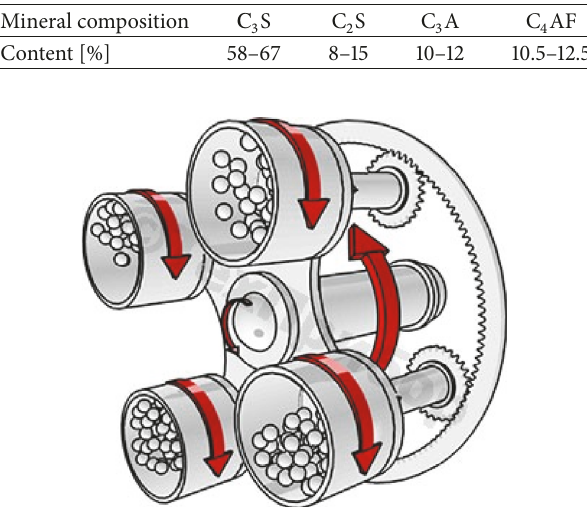
Table 2: The mineral compositions of Spassky Portland cement.